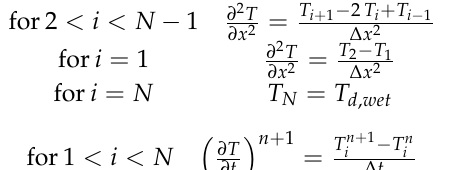
Figure 12. Meshing for finite difference resolution.